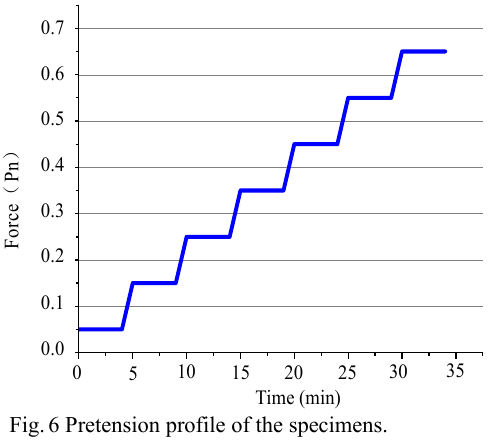
Fig. 6 Pretension profile of the